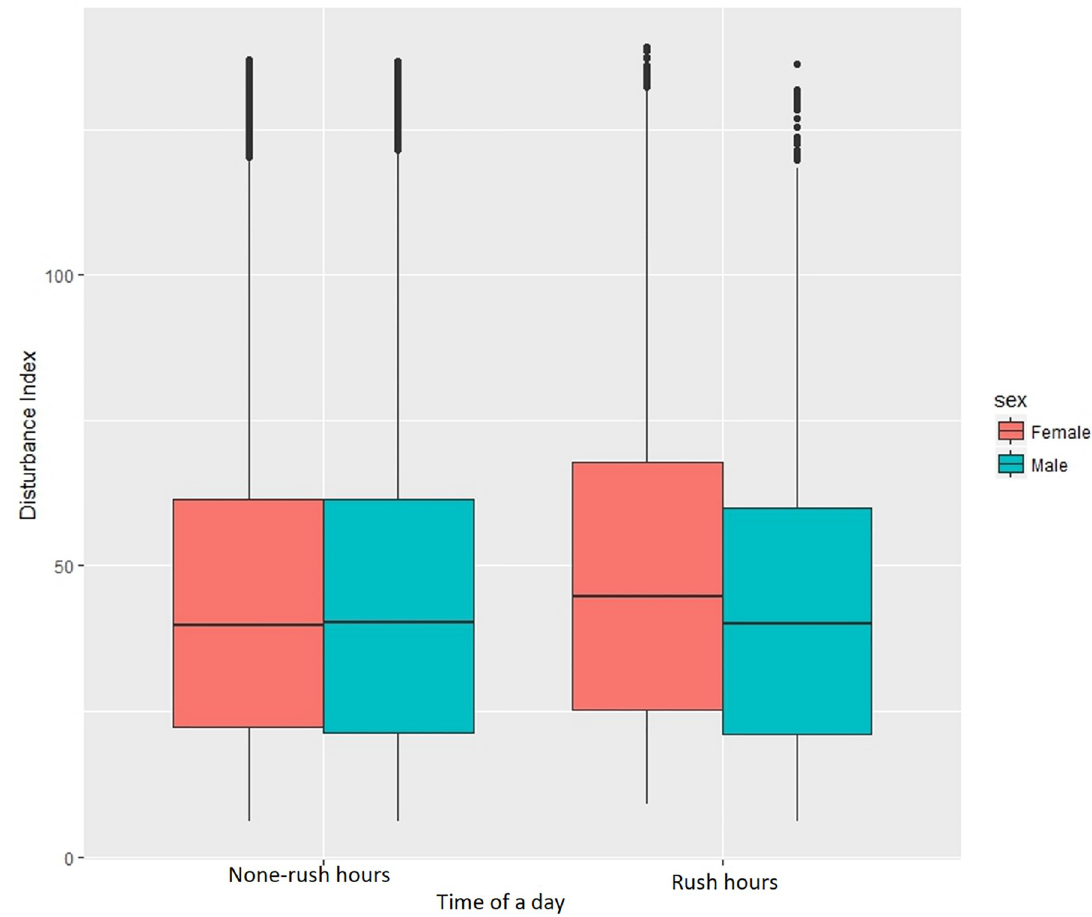
Fig 13. Individual disturbance in rush hour (7:30–9:00am and 4:00–6:00pm) and non-rush hours periods.